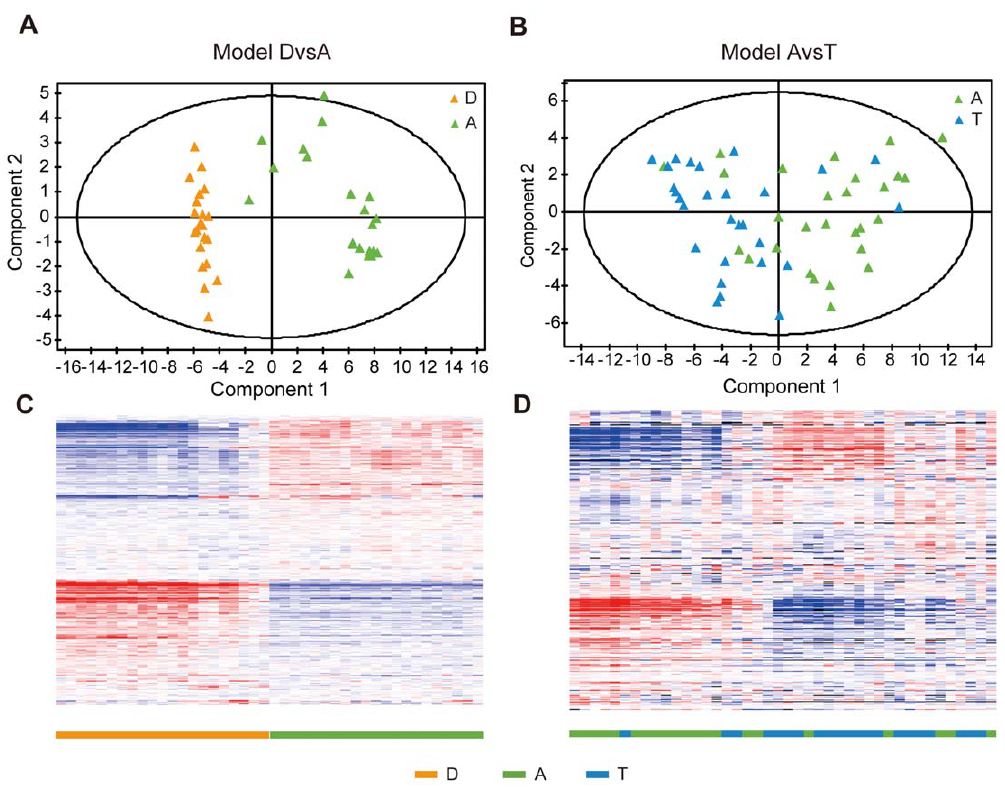
Figure 5. Validation studies of top 547 genes whose expression changed in CD4 + T cells from allergic patients after allergen- challenge and were reversed by treatment with glucocorticoids. The CD4 + T cells from allergic patients were obtained from two independent materials and analysed with gene expression microarrays. PCA ( A and B ) and hierarchical clustering analysis ( C and D ) of Test1 ( A and C ) and Test2 ( B and D ) with the top 547 genes that were changed by allergen challenge and were reversed by GC treatment.